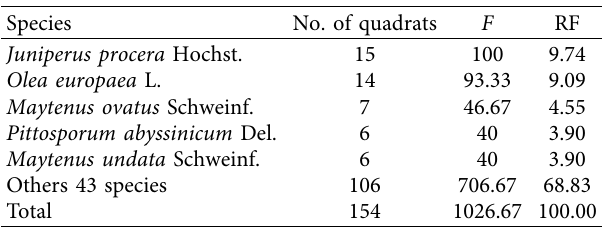
Table 5: Frequency distribution of dominant woody species in